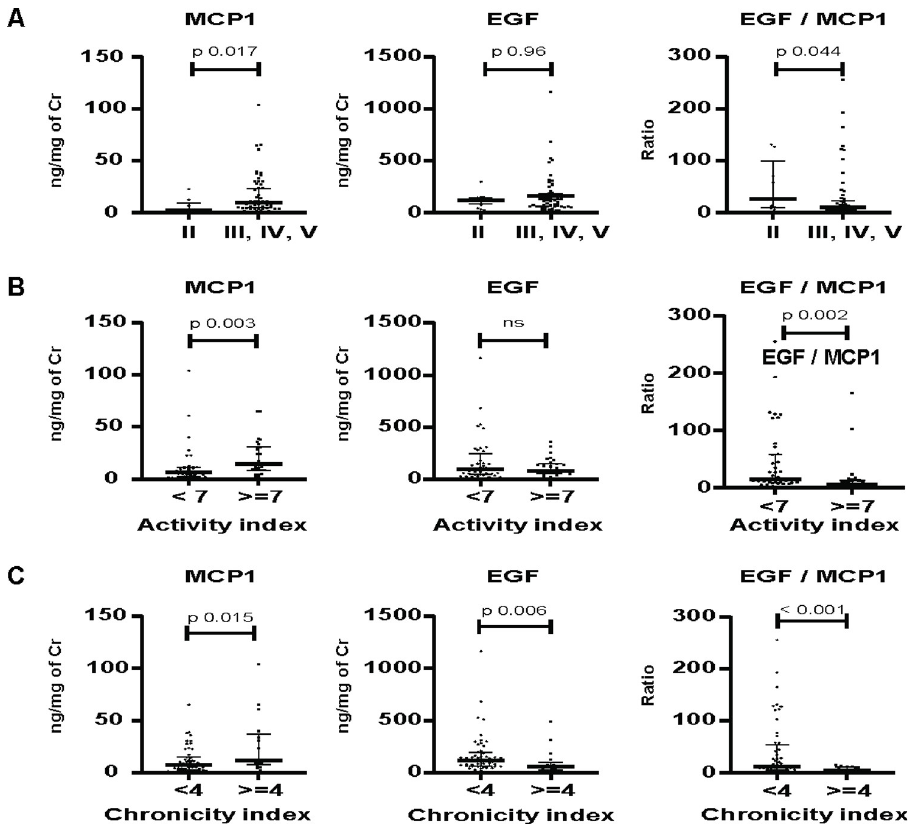
Fig 2. Urine cytokines levels and renal histology (n = 69). a) WHO Class: Class II versus Combined Classes III/IV/V; b) Activity index: (AI High ( � 7) Versus Low ( < 7); c) Chronicity Index (CI): High (( � 7) versus Low ( < 7). Cr,